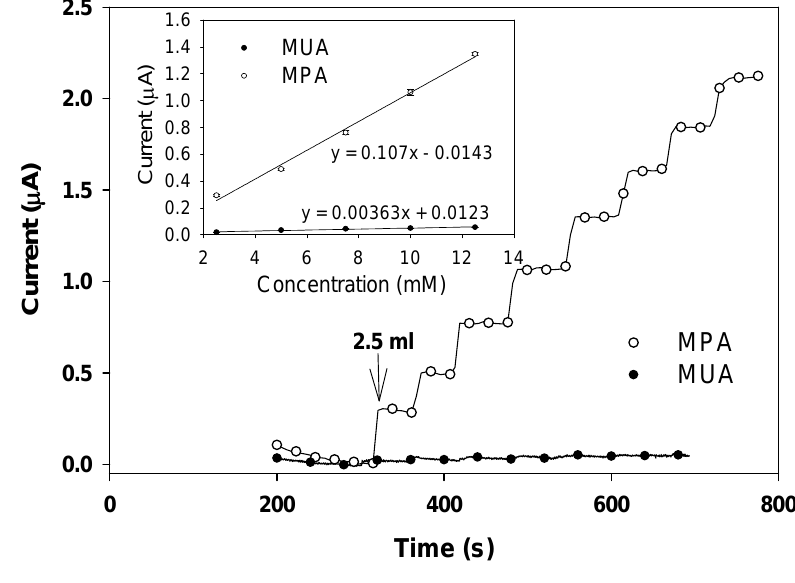
Figure 4. Amperometric current measurements obtained for the MPA and MUA treated 3D electrodes in response to glucose at various concentrations. The inset shows the two linear calibration